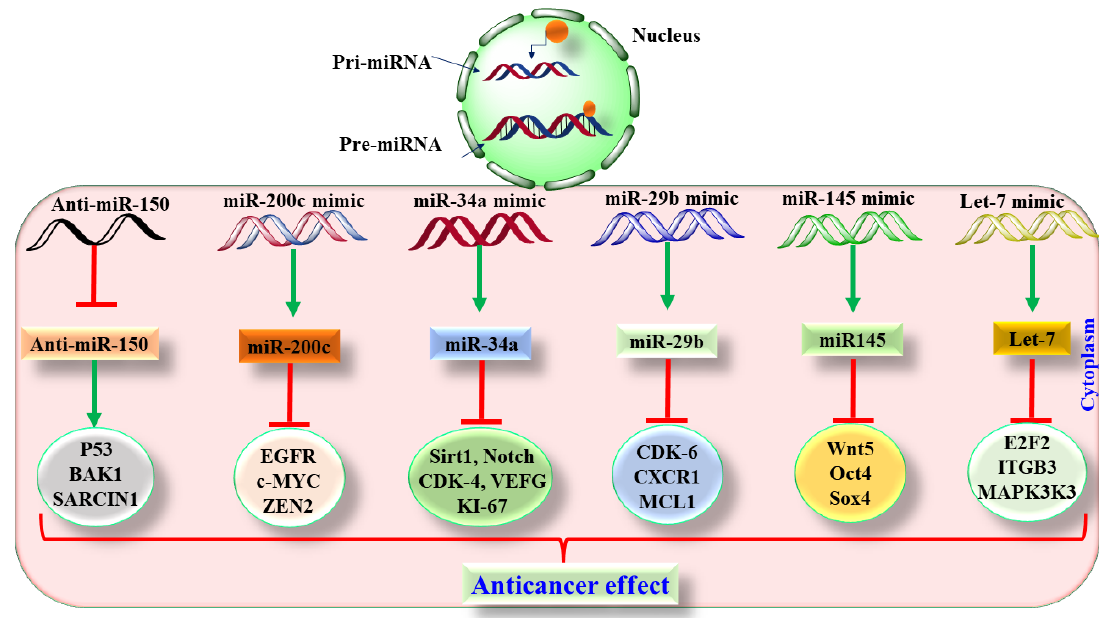
Figure 6. Role of various miRNA in lung cancer.